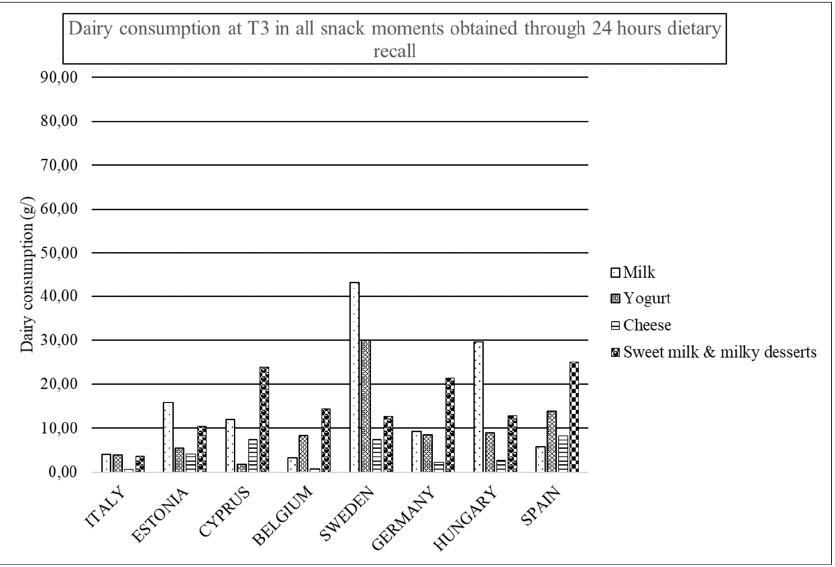
Figure 4. Dairy consumption at T3 in all snack moments obtained through 24 HDR.